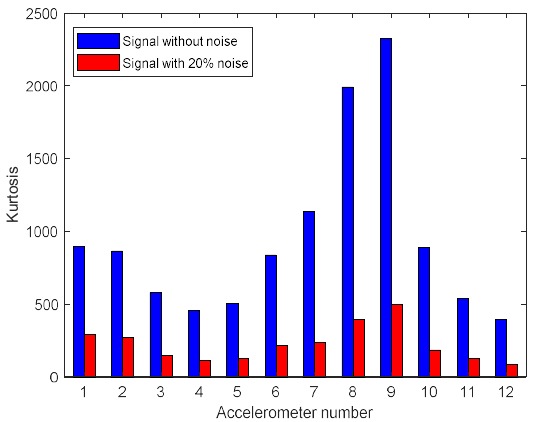
Figure 14. Kurtosis values for signals with and without noise for the Alfa Pendular passage for layout scheme 2.